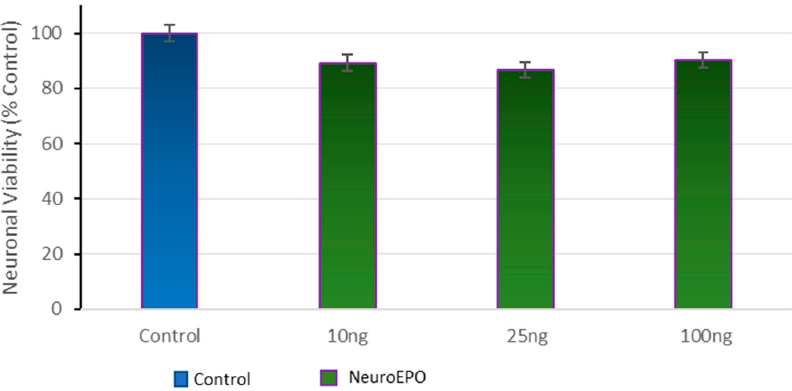
Figure 2. Effects of various concentrations of neuroEPO on cell viability. Primary cortical cells were treated with various concentrations of neuroEPO or in the absence of neuroEPO (control) for 24 h. Cell viability is expressed as the mean (±SEM) from three experiments ( n = 3).